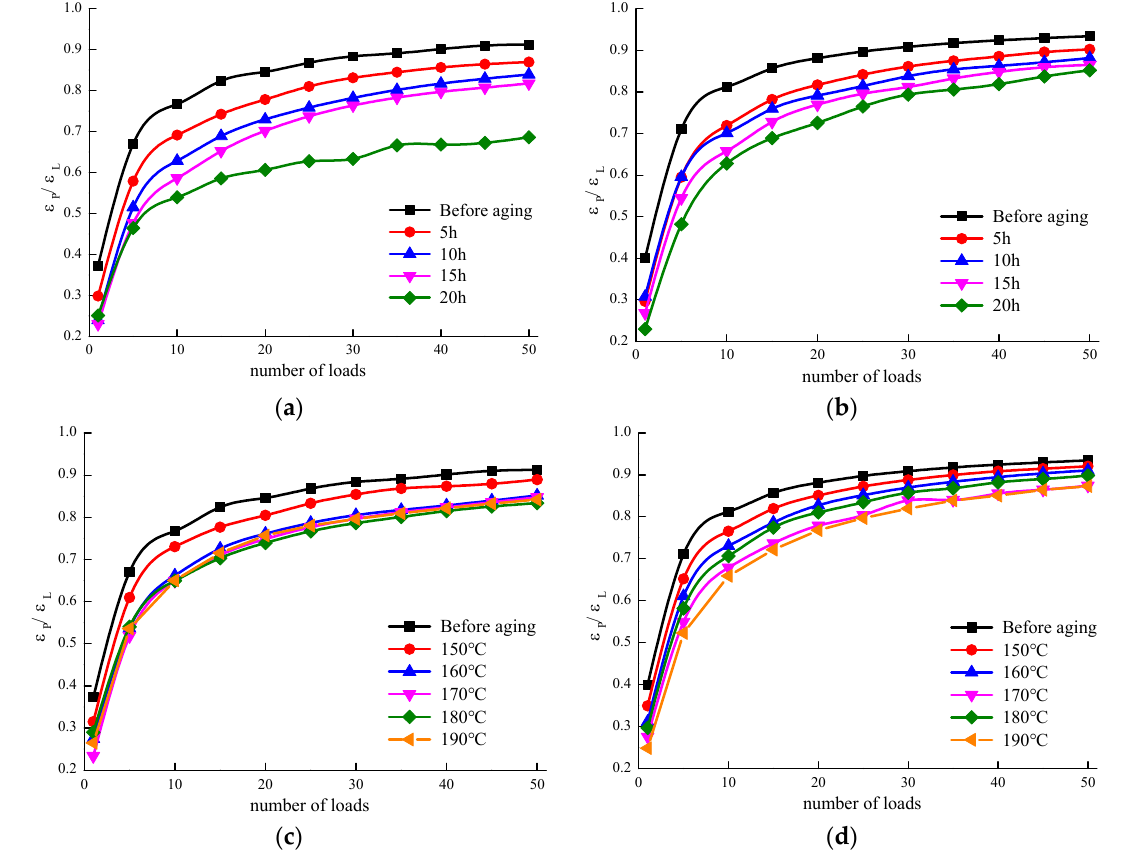
Figure 8. Relationship between ε P/ ε L and load times of asphalt under different aging conditions: ( a ) different aging time at 100 Pa; ( b ) different aging time at 300 Pa; ( c ) different aging temperature at 100 Pa; and( d ) different aging temperature at 300 Pa.